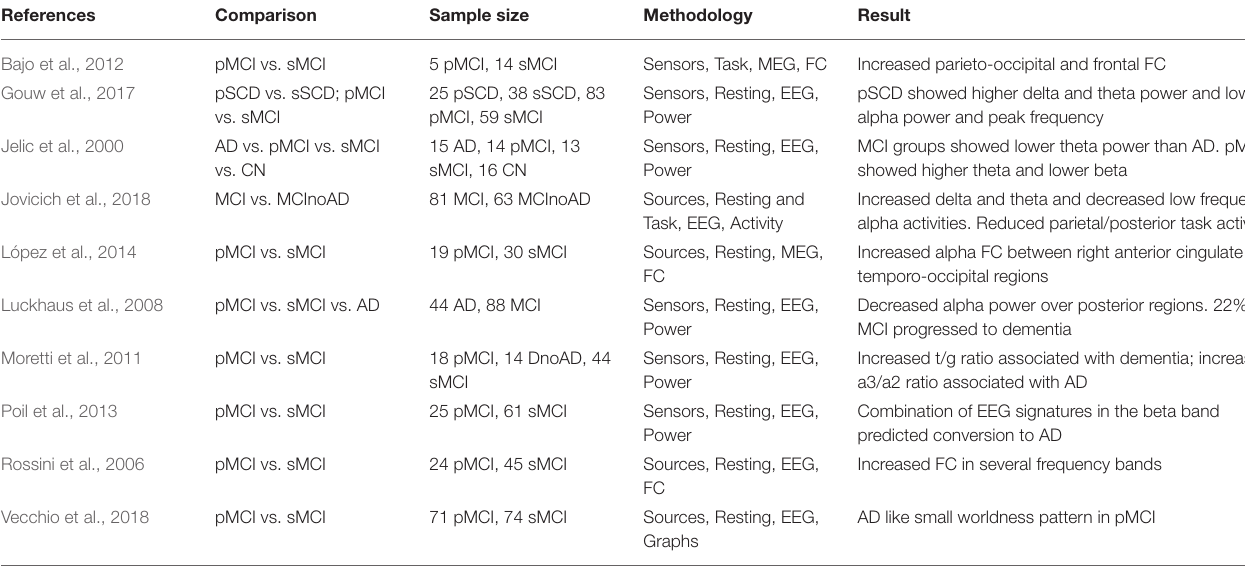
TABLE 2 | Studies of M/EEG on progression along AD